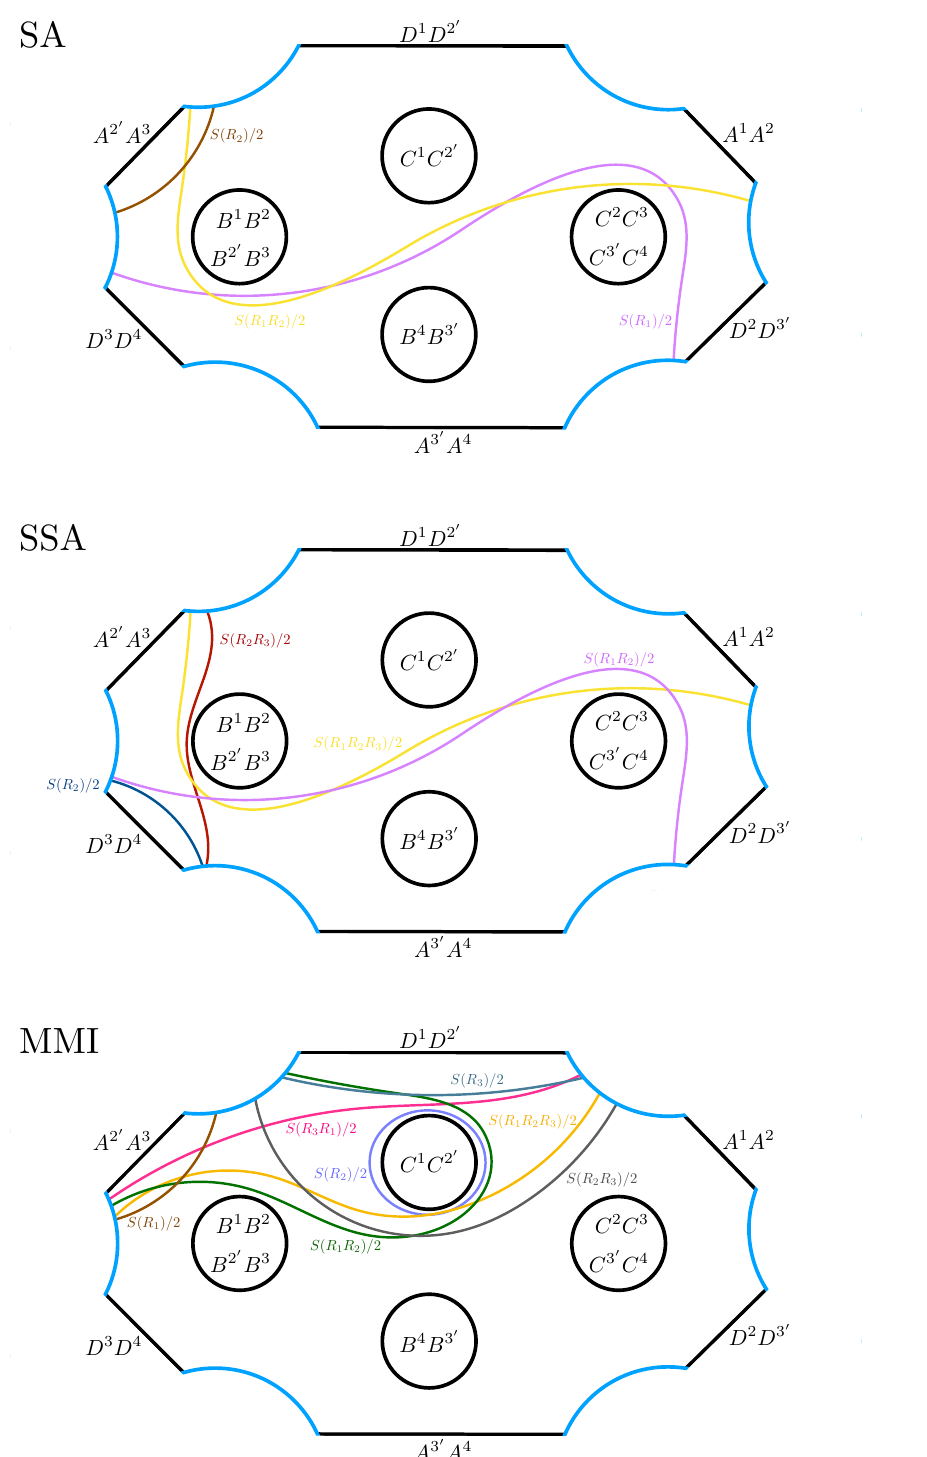
Figure 6 . E W surfaces for the choices of R i in eqs. (3.4), (3.7), and (3.10) (prior to the final doubling of the manifold using the CPT conjugate), where we use SA, SSA, and MMI, respectively, to derive the inequalities in eqs. (3.5), (3.8), and